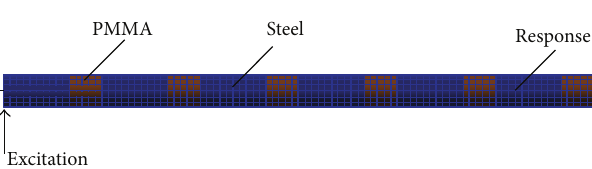
Figure 9: Finite element model of the phononic crystals beam.